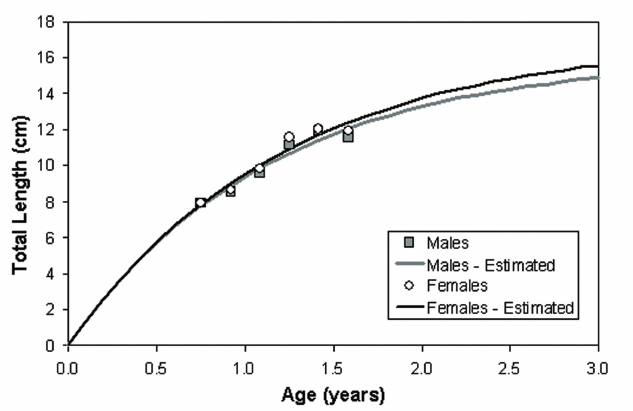
Fig. 5 . Estimated von Bertalanffy growth curves for the silverside Atherinella brasiliensis in Tramandaí Estuary, Southern